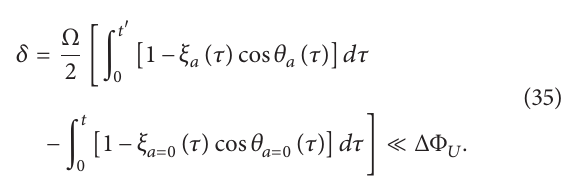
of 133 𝐶𝑠 , for which 𝜔 0 = 1167 . 68 MHz and 𝛾 0 = 28 . 743